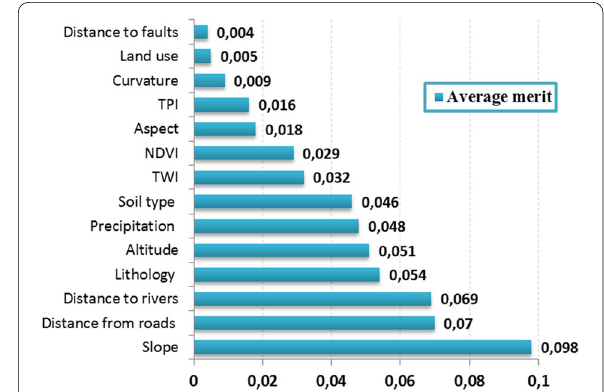
Fig. 5 Predictive capabilities of the fourteen landslide conditioning